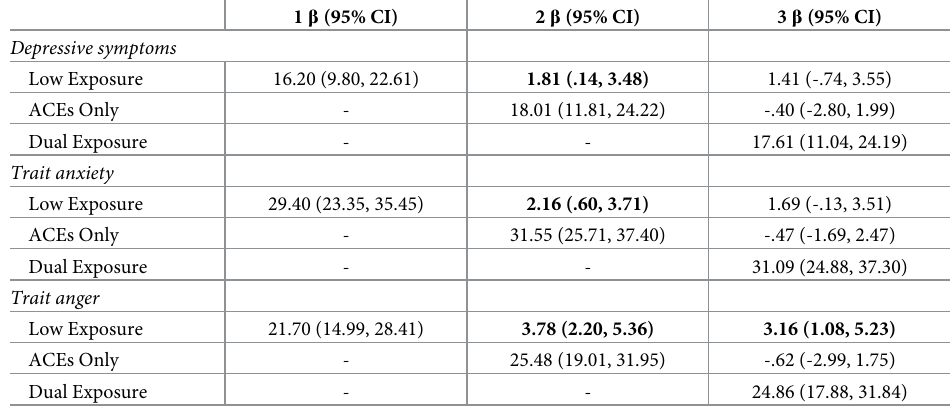
Note . n = 347. Bold font indicates p < .05. Values on the diagonal indicate the mean value of each class as